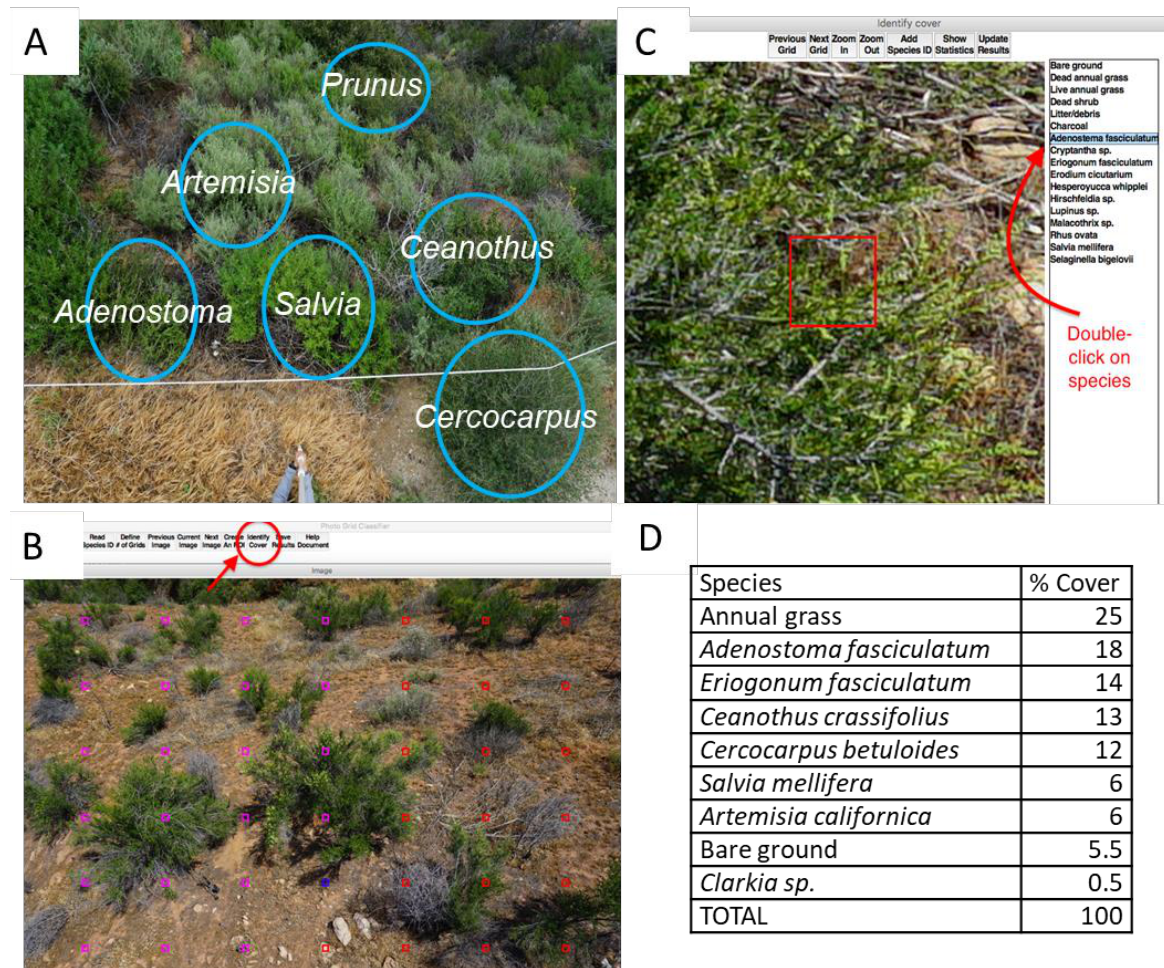
Figure 3. Photogrid classification process: ( A ) in the field, aboveground photos were marked with a smartphone app to aid with later species ID; ( B ) back in the lab, photos were uploaded into the Photogrid classifier program and number of gridpoints per photo (generally 42) were chosen, which instructs the program to populate each photo with gridpoints to classify; ( C ) for each gridpoint, the user must select the dominant species/cover class within that cell from a pre-entered list; ( D ) after completing classification for all ten plot photos, a table is generated with percent cover of each class identified, out of 100% (Annual Grass was a composite category that included annual grass species that could not be distinguished in the photos such as Bromus spp., Avena spp., etc.).